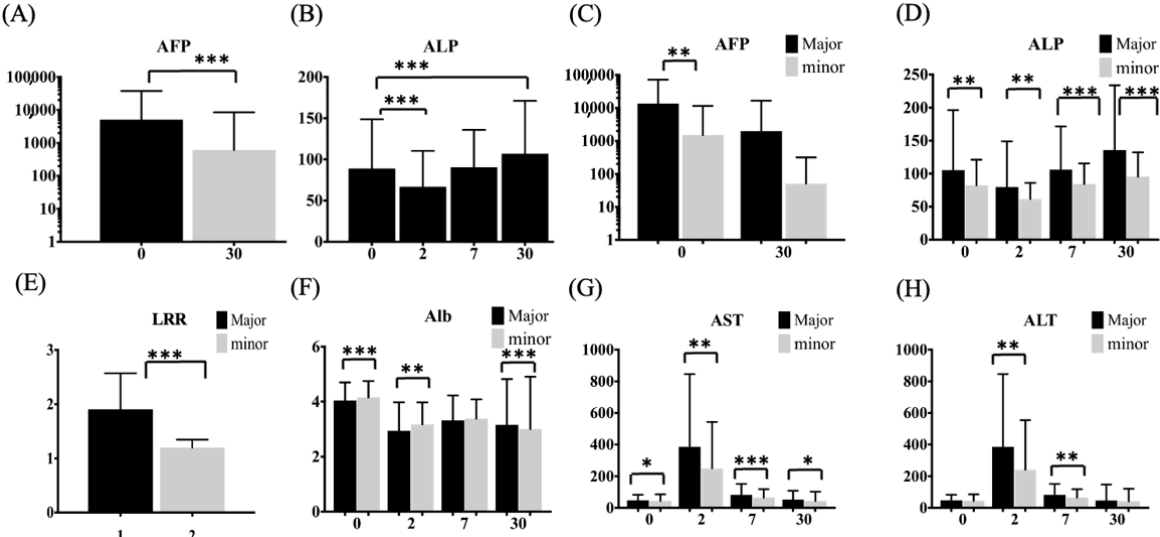
Figure 4. Change in AFP and liver-function tests in the perioperative period between major and minor hepatectomies for HCC. ( A ) and ( B ) AFP was significantly decreased after operation, but ALP was significantly decreased at POD 2 and increased at POD 30 according to paired t-test. Patients with HCC had dynamic liver functional changes. ( C ) AFP showed significantly different between major and minor groups on POD 0. AST ( G ), ALT ( H ), ALP ( D ), albumin ( F ) and AFP showed significant differences in major and minor hepatectomies. The liver regeneration ratio ( E ) was calculated with postoperative liver volume/estimated preserved liver volume. The regeneration ratios were 1.91 ± 0.66 and 1.20 ± 0.15, respectively ( p < 0.001). However, there was a dynamic change after partial hepatectomies, but ALP was significantly increased in both groups at POD 7 and POD 30. Abbreviations: aspartate aminotransferase (AST), alanine aminotransferase (ALT), alkaline phosphatase (ALP), and albumin (Alb). * Statistical significance (* p < 0.05, ** p < 0.01, *** p < 0.001).